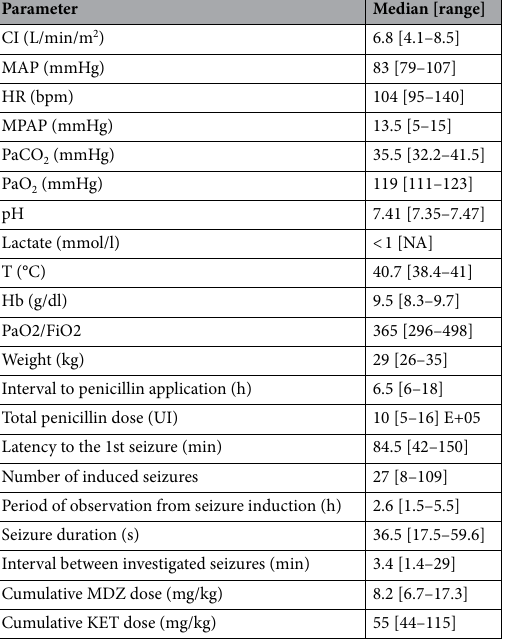
Table 1. Summary of systemic, biological parameters and information at time of penicillin application in the studied animals. CI Cardiac index, MAP Mean arterial pressure, HR Heart rate, MPAP Mean pulmonary arterial pressure, T Temperature, °C Celsius degrees, Hb Hemoglobin, MDZ Midazolam, KET Ketamine, NA Not applicable. Data are presented as median and